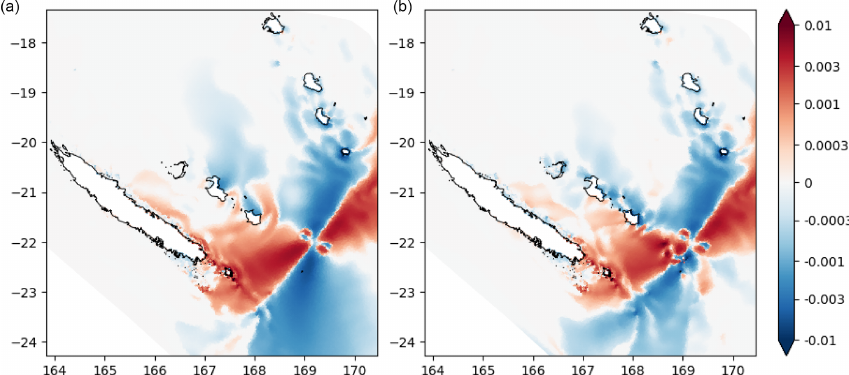
Figure 10. Spatial distribution of d H max across the model domain for the case with the simplified Loyalty Ridge (a) ; the case with preserved d (cid:56) bathymetry (b) . Scale bar units are in centimeters per